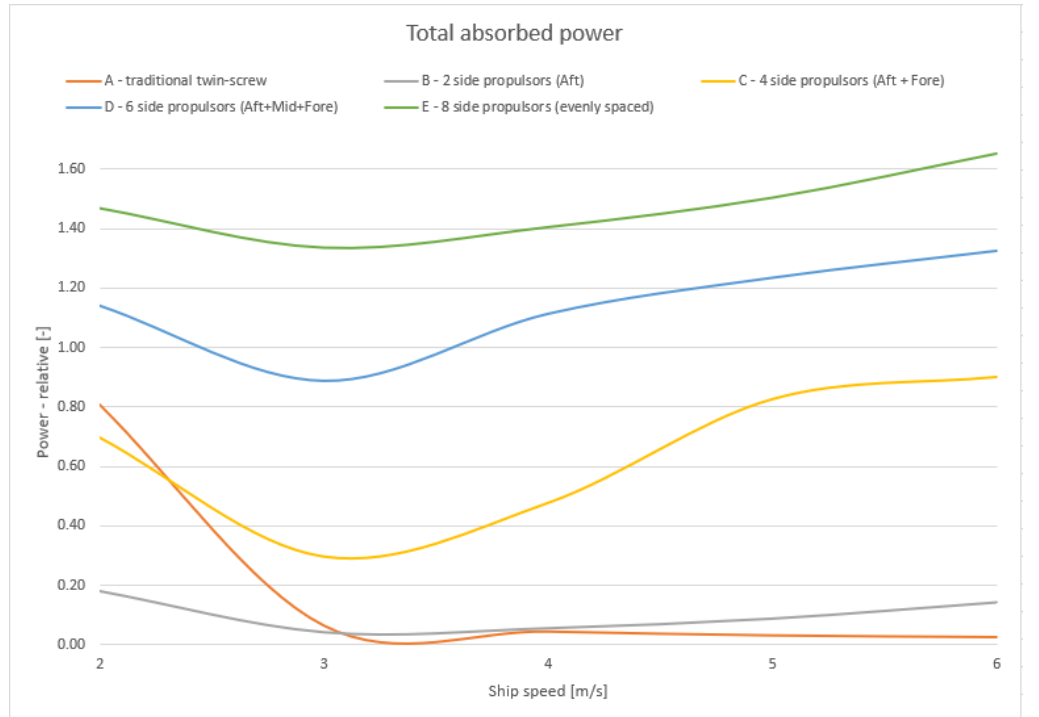
Figure 10. Total absorbed power, deep water (comparison). Source: Authors.